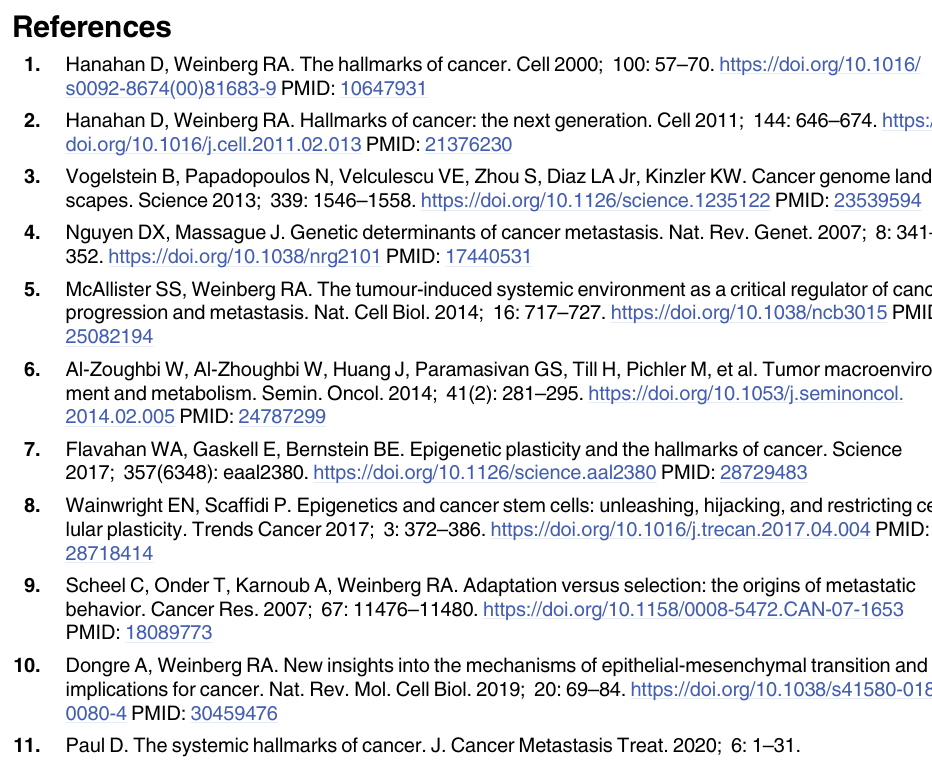
S2 File. Protein IDs associated with the cell-membrane and the cancer hallmark processes, detected cell-membrane proteins, and degree/betweenness centrality measurements. S1 Fig. Extended PPI networks mapped to the cancer